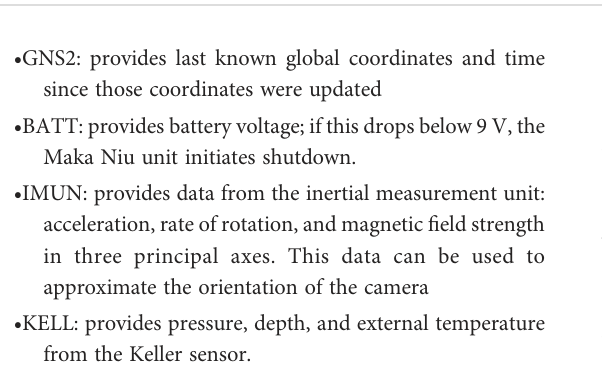
FIGURE 6 Maka Niu logs metadata for every image and for every second of video or duration of a mission. This particular log reveals that on September 29, 2021, at 1AM UTC time, the camera was in the Santa Monica Basin, it was nearly fully charged, it was oriented horizontally at the surface, and the temperature in its environment was